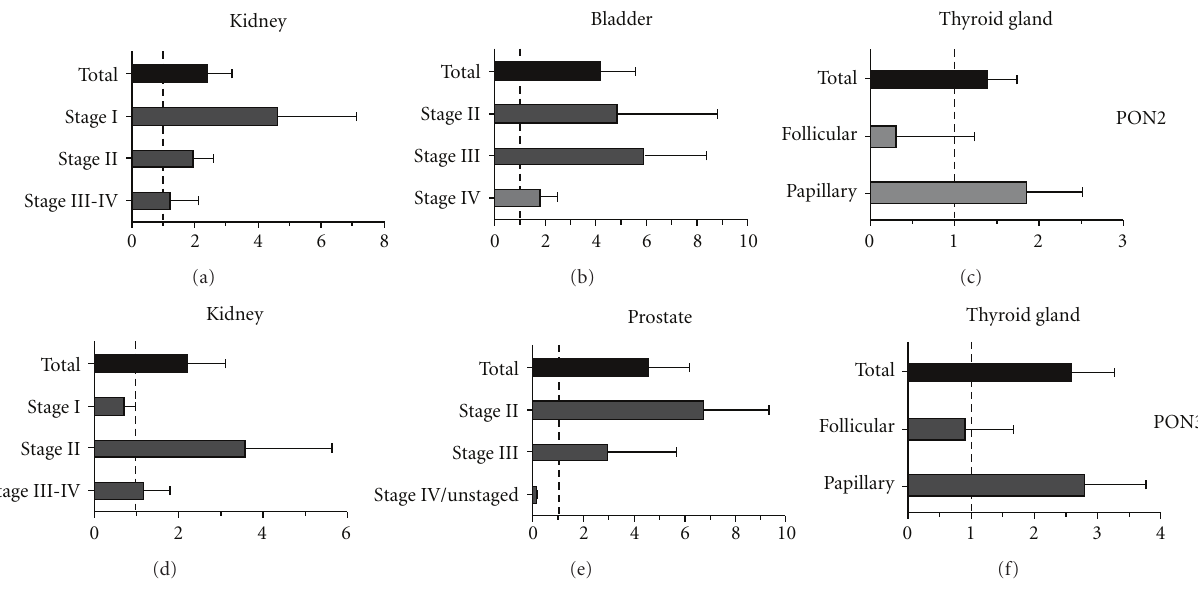
Figure 1: PON2 and PON3 are found overexpressed in early rather than late stages of tumors. Indicated cancer tissues were analyzed for PON2/PON3 cDNA levels (normalized to GAPDH) relative to healthy controls. Values were taken from recently performed arrays [23,